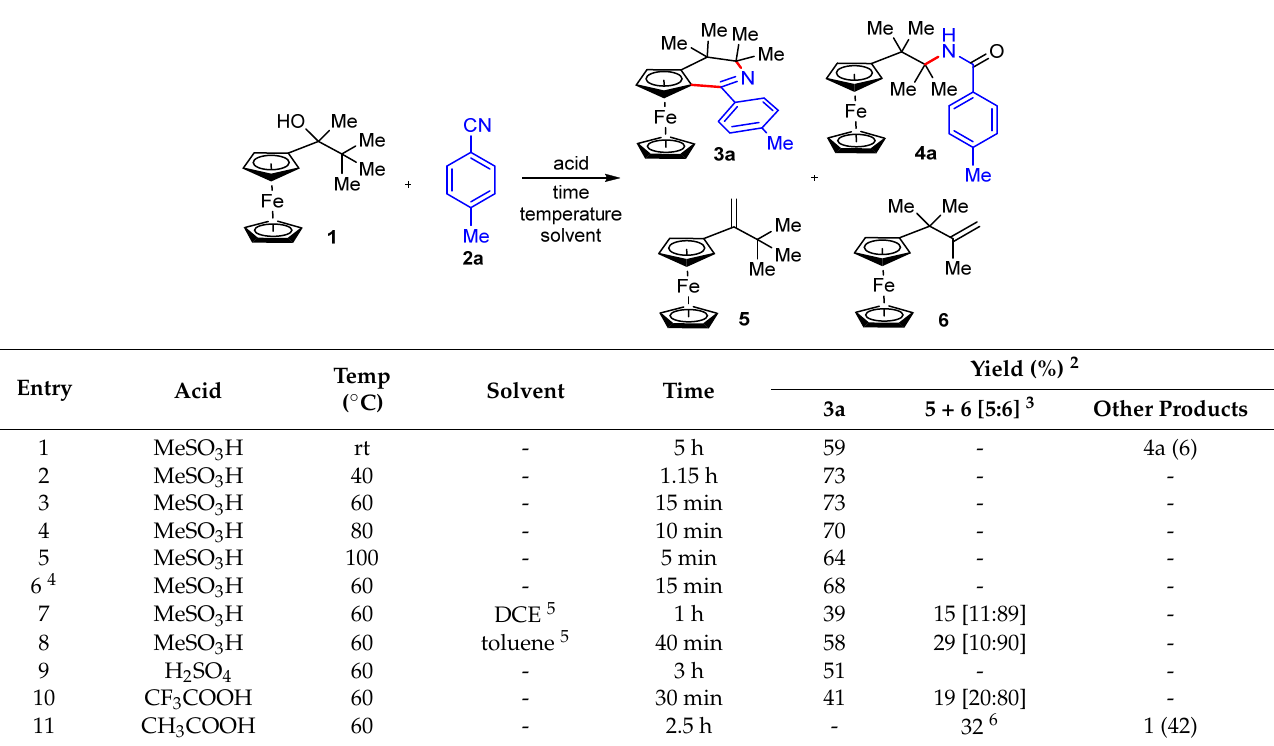
Table 1. Reaction of alcohol 1 with 4-methylbenzonitrile ( 2a ). Optimization of the reaction condi- tions. 1